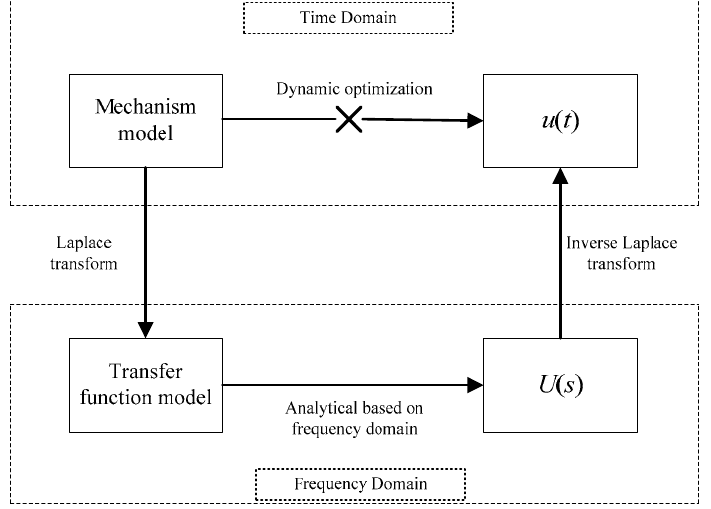
Figure 1. A-FD-based solution of continuous transition strategy with physical significance.